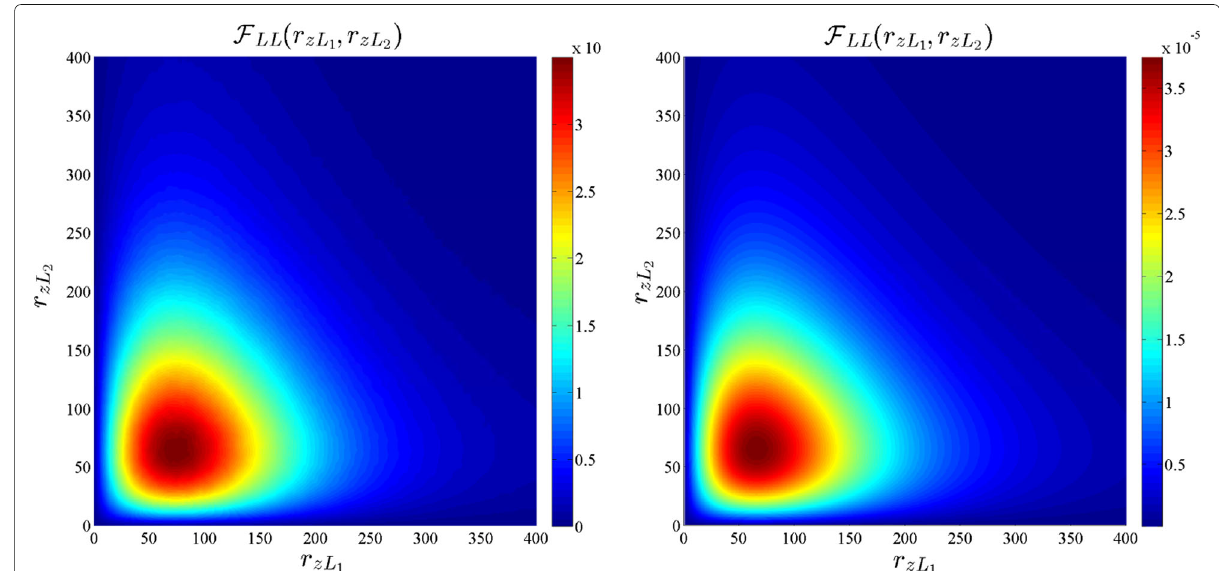
Fig. 3 Joint densities of R zL 1 and R zL 2 for the actual PPP model (left) and the independence assumption (right). R zL 1 and R zL 2 are the distances of LOS users to their respective BSs in two neighboring cells